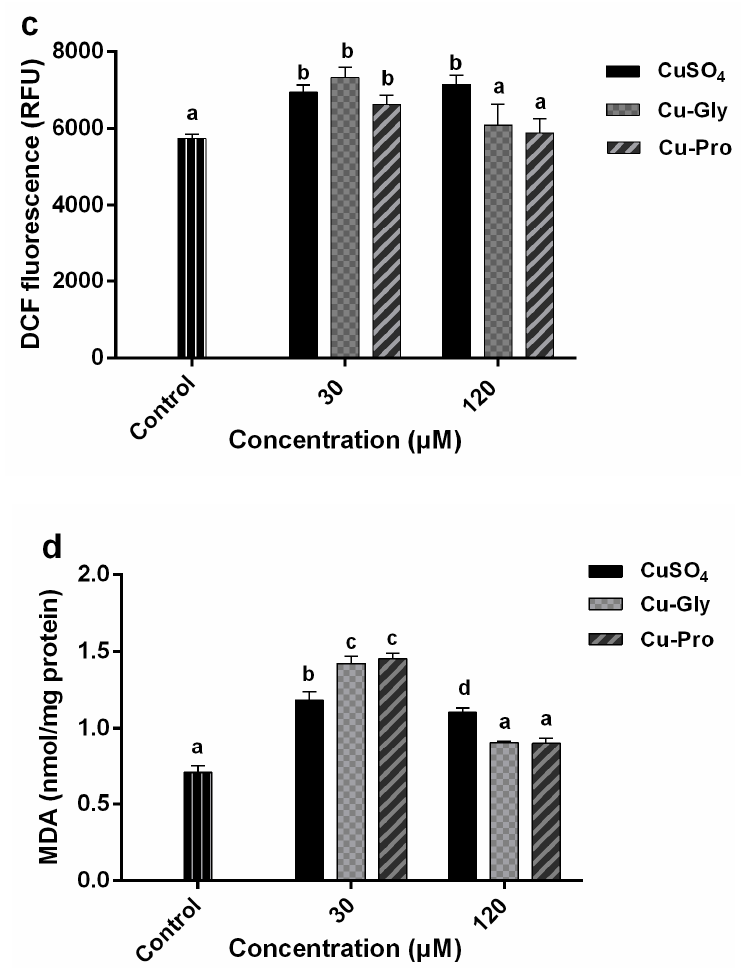
Figure 3. Copper induced oxidative stress in porcine small intestinal epithelial (IPEC-J2) cells. Cells were treated with CuSO 4 , Cu-Gly, and Cu-Pro at the concentrations of 30 and 120 µ M for 10 h. ( a ) Total superoxide dismutase (SOD) activity was assessed using an assay kit. The result was expressed as a percentage of the control. ( b ) SOD1 protein expression levels were measured by Western blotting. The densitometry of blot images normalized to β -actin levels for each lane. ( c ) Reactive oxygen species (ROS) was determined by using 2, 7-dichlorofluorescin diacetate (DCFH-DA). ( d ) Malondialdehyde (MDA) was measured by an acid reactive substance (TBARS) assay. The result was corrected with the total protein content of cells. Data represent mean values ± standard deviation ( n = 3). Significant di ff erences between processing groups are represented by di ff erent lowercase letters ( p <